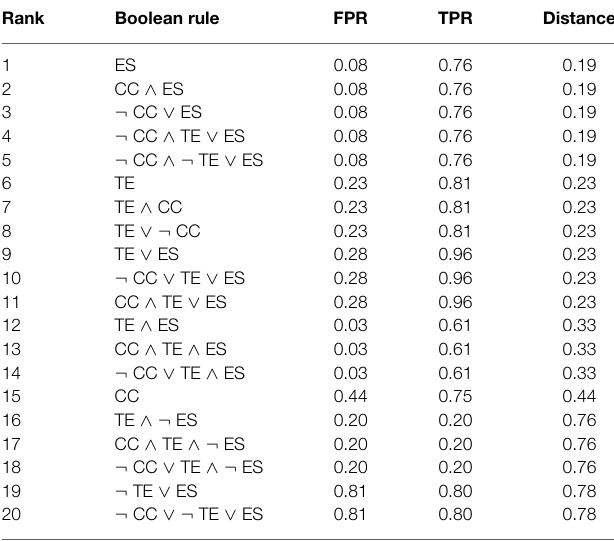
TABLE 1 | Performance of 20 select Boolean rules on the synthetic dataset of data-driven model of fish social behavior. Rank Boolean